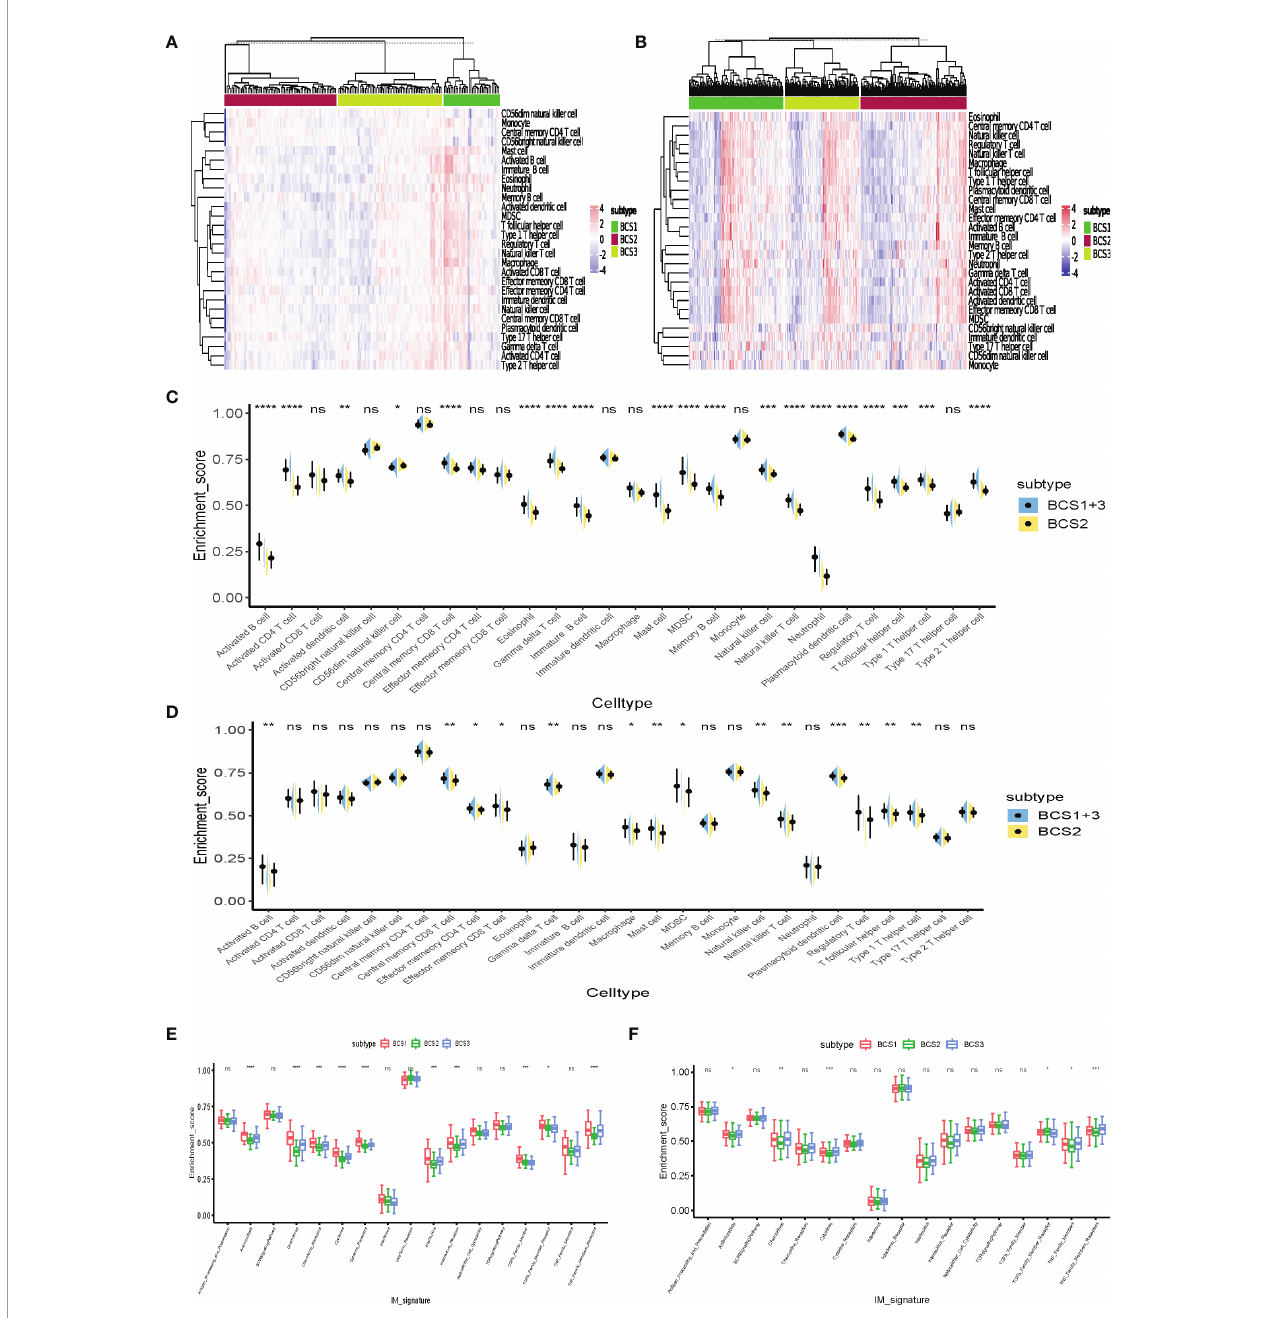
FIGURE 7 | Immune cell in fi ltration of distinct immune subtypes. (A) Differential enrichment scores of 28 immune cell signatures among the BLCA immune subtypes in the GEO cohort. (B) Differential enrichment scores of 28 immune cell signatures among the BLCA immune subtypes in the TCGA cohort. (C, D) Differential enrichment scores of 28 immune cell signatures between BCS2 and other types in the GEO (C) and TCGA cohorts (D) . (E, F) Differential enrichment scores of 17 immune-related signature pathways among BLCA immune subtypes in the GEO (E) and TCGA (F) cohorts. * P < 0.05, ** P < 0.01, *** P <0.001, **** P <0.0001, and ‘ ns ’ represents not signi fi